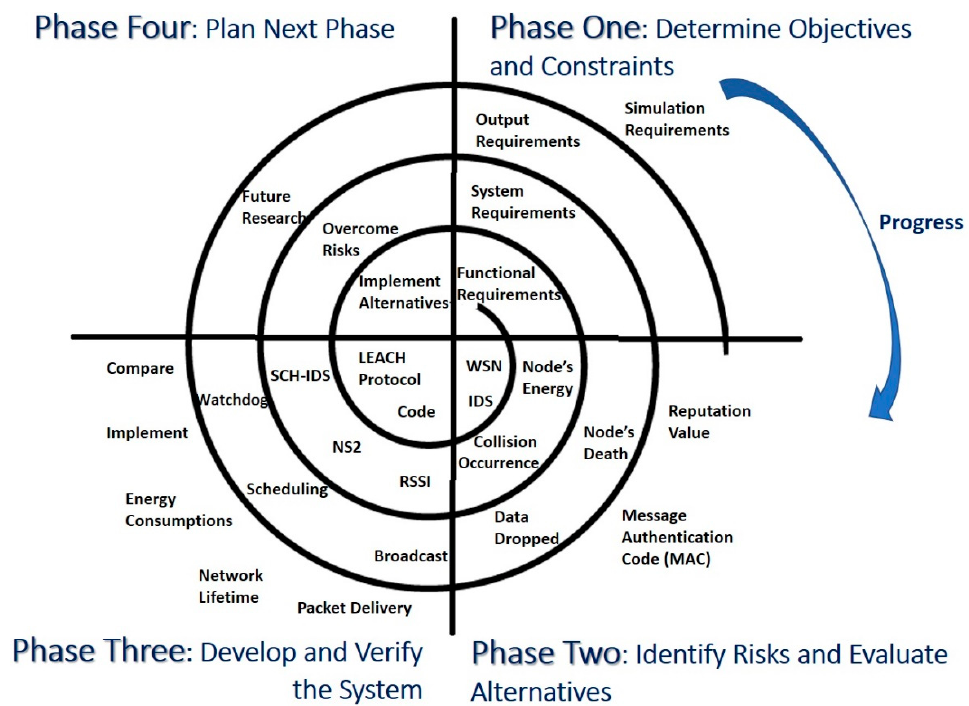
Figure 5. Applying the spiral model to the development of IDS in WSNs.